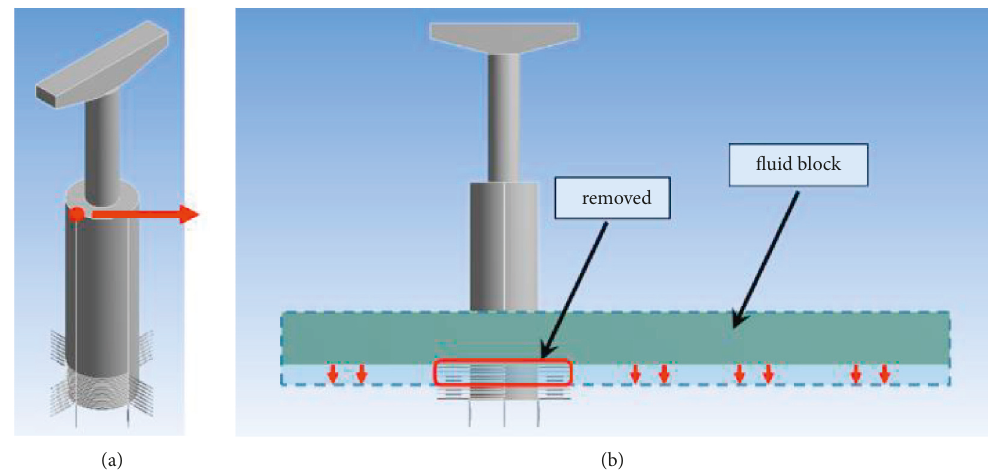
Figure 8: The simulation of the scour process. (a) Pile top displacement. (b) Removal of embedded depth.